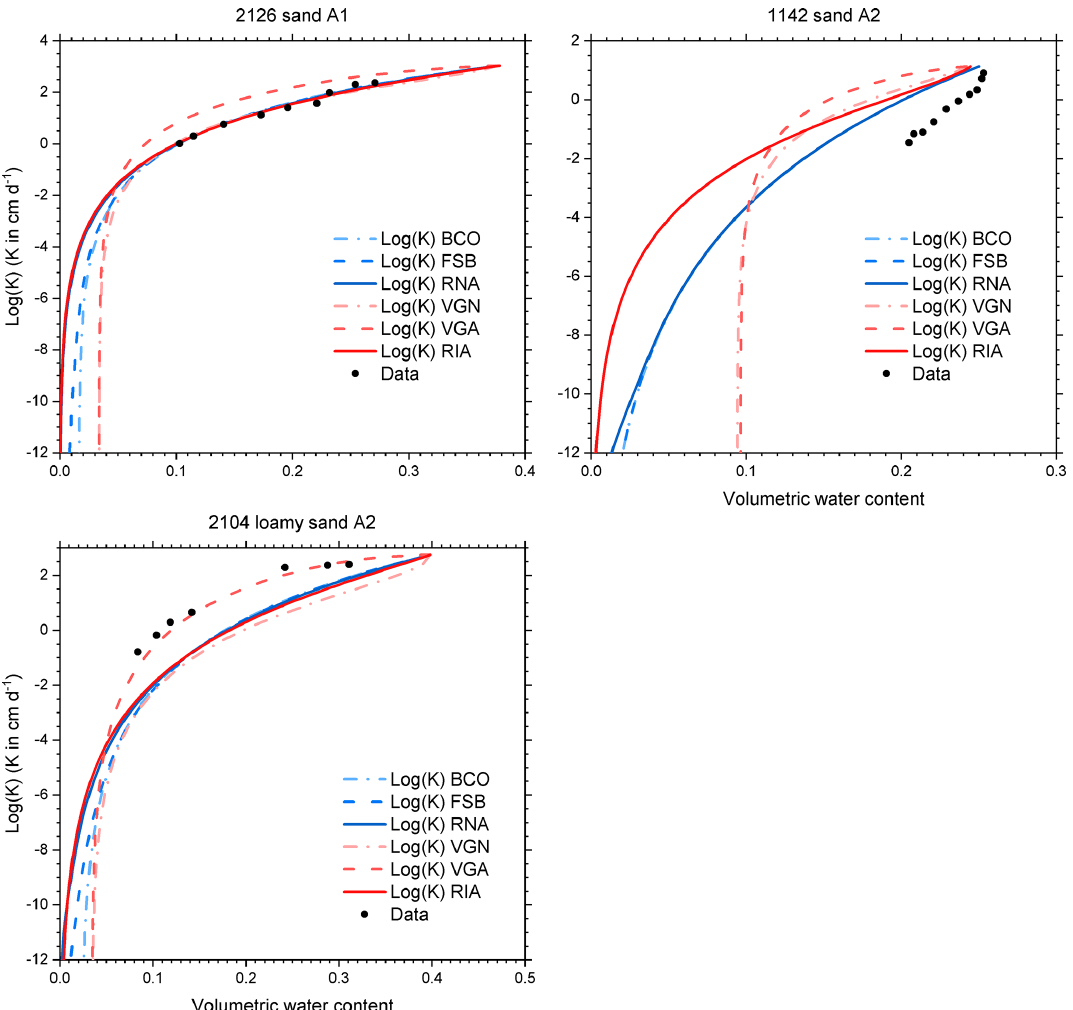
Figure C6. Conductivity data and conductivity curves derived from the retention curves of Fig. C2, according to six parameterizations for selected UNSODA soils with the A1 or A2 classification of Twarakavi et al.